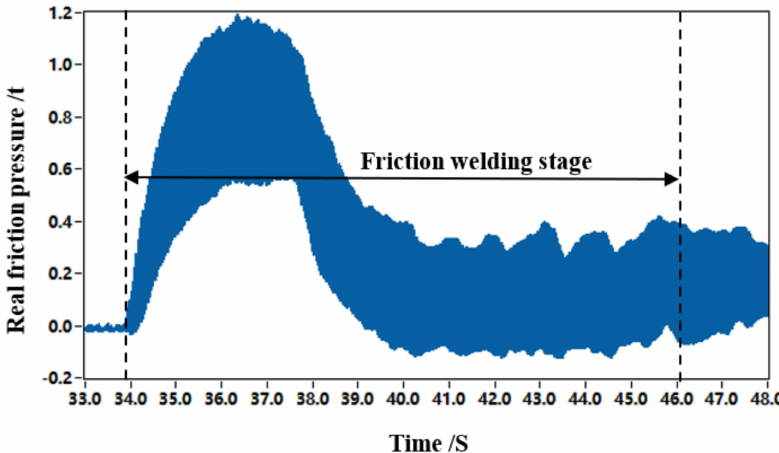
Figure 4. Friction pressure curve of LFWed No. 9 joint.